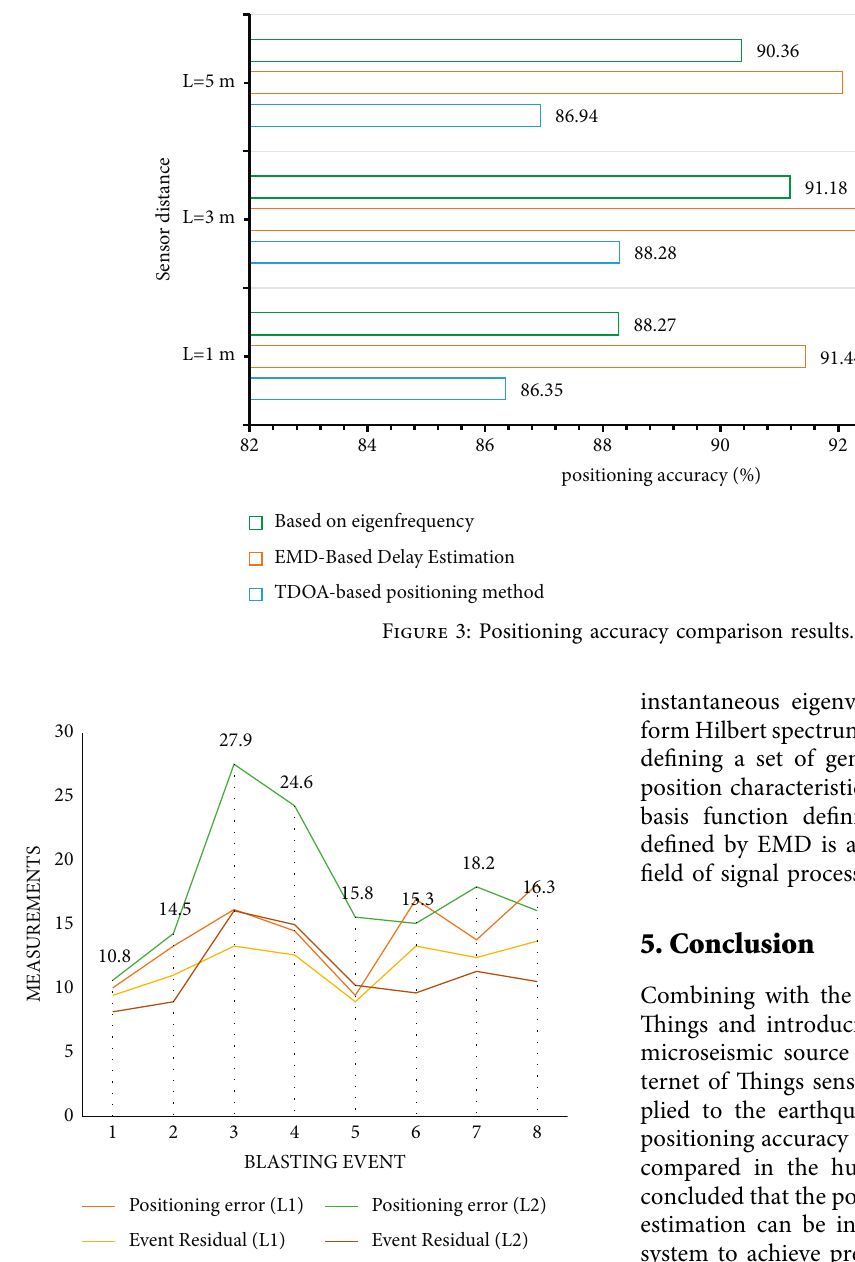
Figure 4: Comparison of localization errors and event